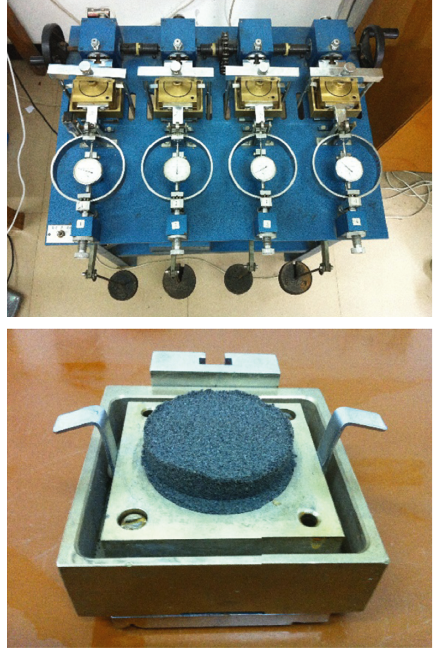
Figure 7: Direct shear test and shear failure of